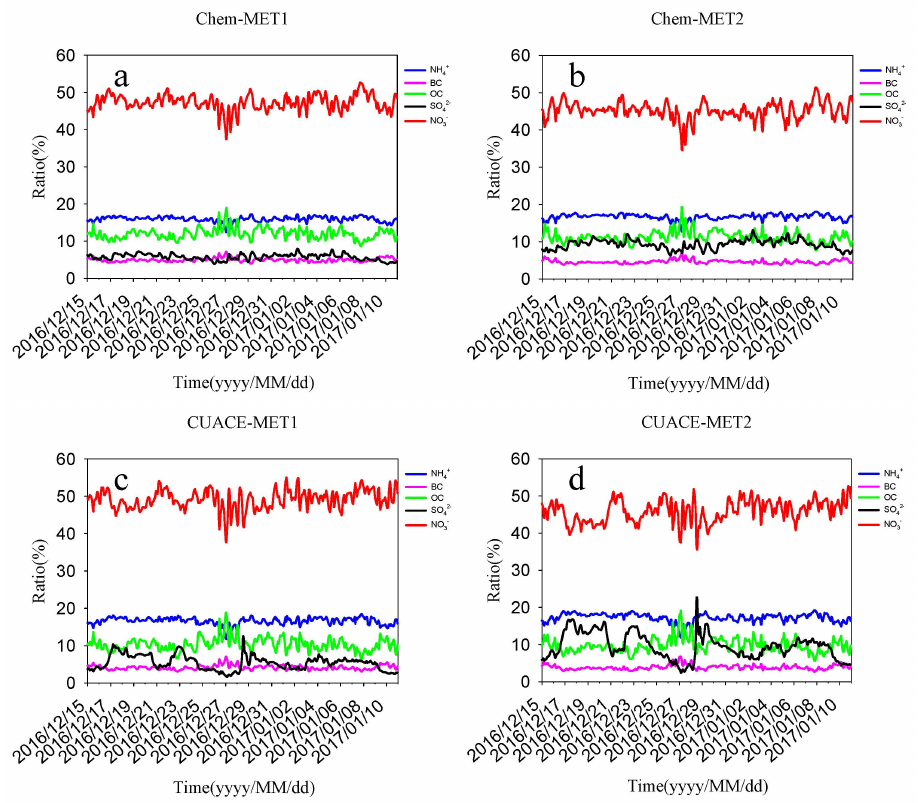
Figure 9. Hourly time series of concentration ratios of ion ammonium salt (blue solid line), BC (purple solid line), OC (green solid line), sulfate (blue solid line), and nitrate (red solid line) simulated by Chem-MET1 ( a ), Chem-MET2 ( b ), CUACE-MET1 ( c ) and CUACE-MET2 ( d ) (unit: µ g m − 3 ) (unit: